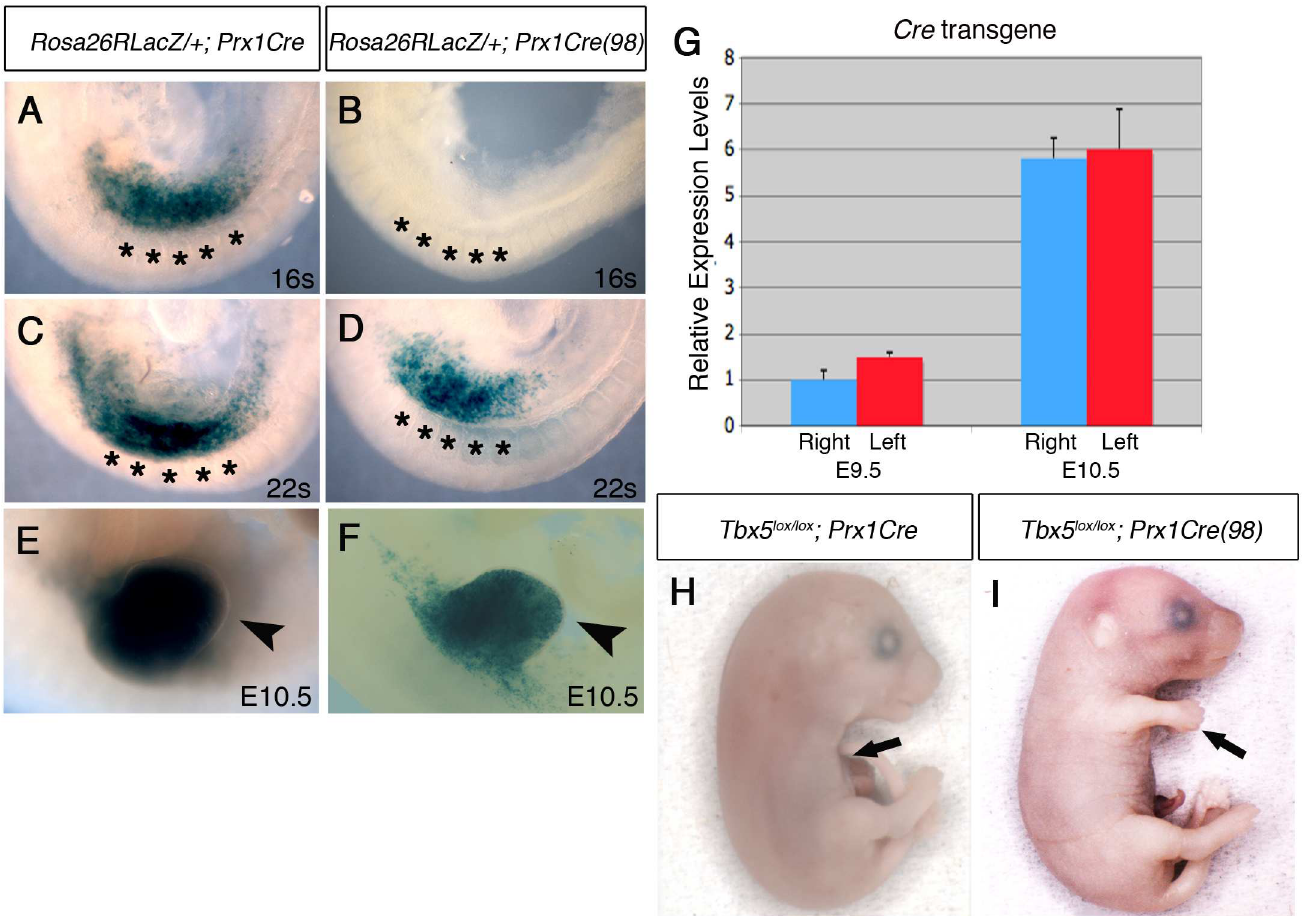
Fig 3. Comparison of Cre activity in Prx1Cre and Prx1Cre(98) transgenic deleter lines. A-F , Lateral views of right side of embryos are shown. LacZ staining of Rosa26RLacZ/+;Prx1Cre embryos(A, C and E) and Rosa26RLacZ/+;Prx1Cre(98 ) embryos (B, D, and F). In the Prx1Cre line, Cre is active throughoutthe forelimb-forming region(marked by black asterisks in the adjacent somites) by 16 somites stage (A) whilecre activity is not detected in Rosa26RLacZ/+;Prx1Cre(98) at this stage (B). At 22 somites stage, staining is seen throughoutthe nascentforelimb bud as well as the LPM rostral and caudalto the forelimb-forming regionin Rosa26RLacZ/+;Prx1Cre embryos (C). At this stage cre is active in the nascent forelimb bud of Prx1Cre(98) embryo in a ‘salt and pepper’mosaic manner (D). At E10.5 strong stainingis observedthroughoutthe forelimbbuds of Rosa26RLacZ/+; Prx1Cre (E, arrowhead)and in a mosaic manner in the forelimb buds of Rosa26RLacZ/+;Prx1Cre(98) embryo (F, arrowhead). G, qPCR analysisof left and right forelimbbuds of Prx1Cre(98) embryos. Cre mRNA is expressedat a similar level on both sides. H , All the elementsof the forelimbhave failed to form in E17.5 Tbx5 lox/lox ;Prx1Cre embryo (arrow). I , Abnormalforelimbs are formed in E17. 5 Tbx5lox/lox ;Prx1Cre(98) embryo